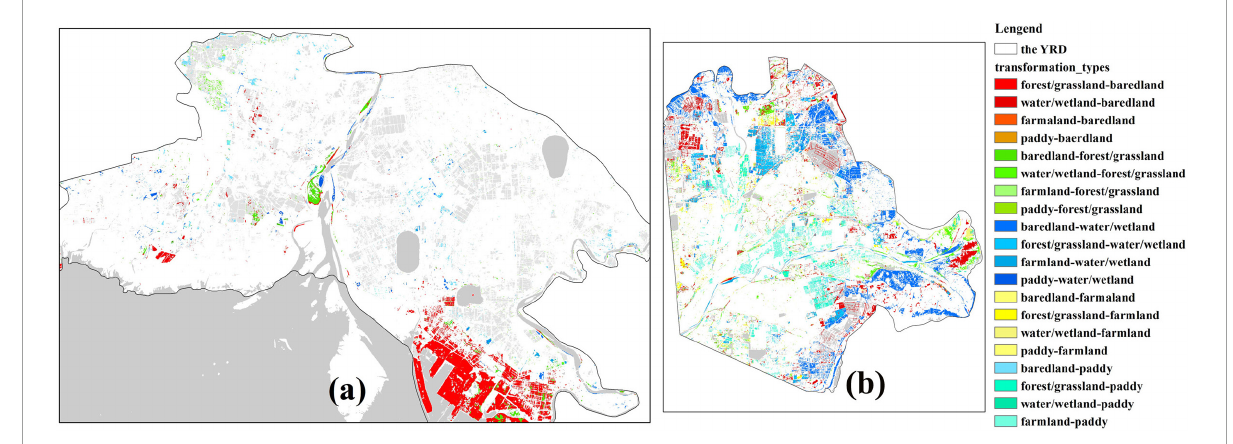
FIGURE7 The inter-annual transformation types of land-cover from 2005 to 2015 in the (a) Shuangtai Estuary and (b) Yellow River Delta.